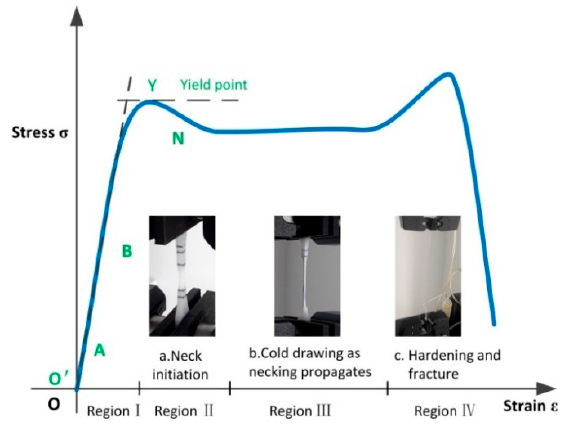
Figure 3. Typical engineering stress-strain curve of semi-crystalline polymer.